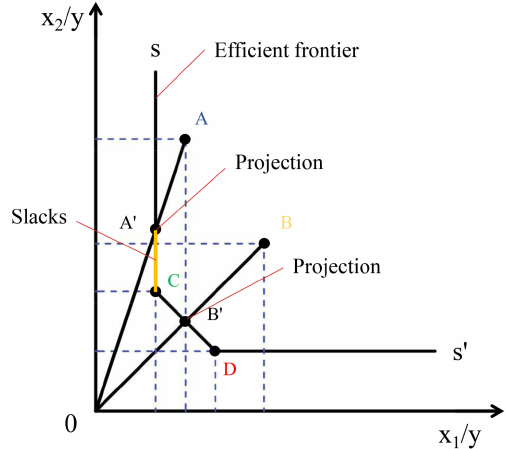
Figure 7. Basic principle of the input-oriented CCR-DEA